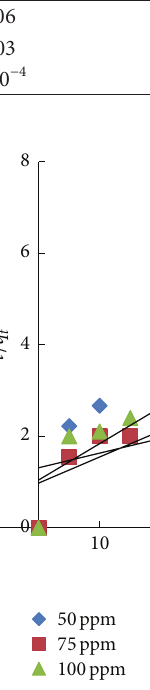
Table 4: Parameters calculated from pseudo-first-reaction kinetic equation for basic violet 16 onto composite sheet matrix. Initial lead conc. (mg/L)